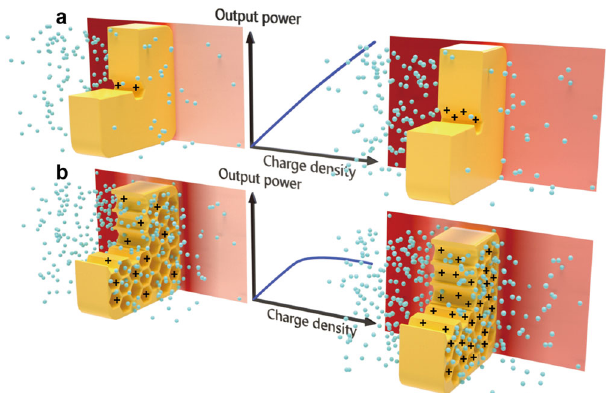
Fig. 1 Anomalous power generation ef fi ciency of COF membranes in response to charge variations. a The existing paradigm of single-pore membranes, in which power generation can be substantially augmented with increasing surface charge. b Relationship between the charge densities of isostructural COF membranes and the corresponding output power densities, as determined by our research. The degree of red shaded background represents ion